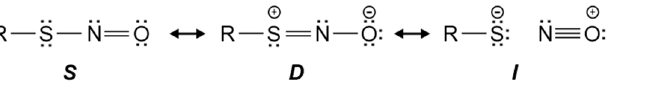
Figure 7. Resonance structures of S-nitroso group according Thalipov and co-workers [60] computa- tional calculations.